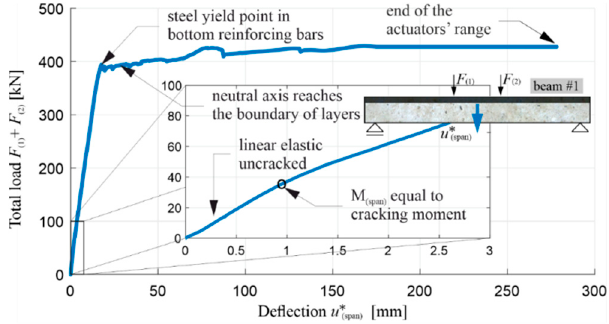
Figure 22. Diagram of the total load in the function of the deflection at the middle of the span for beam #1.